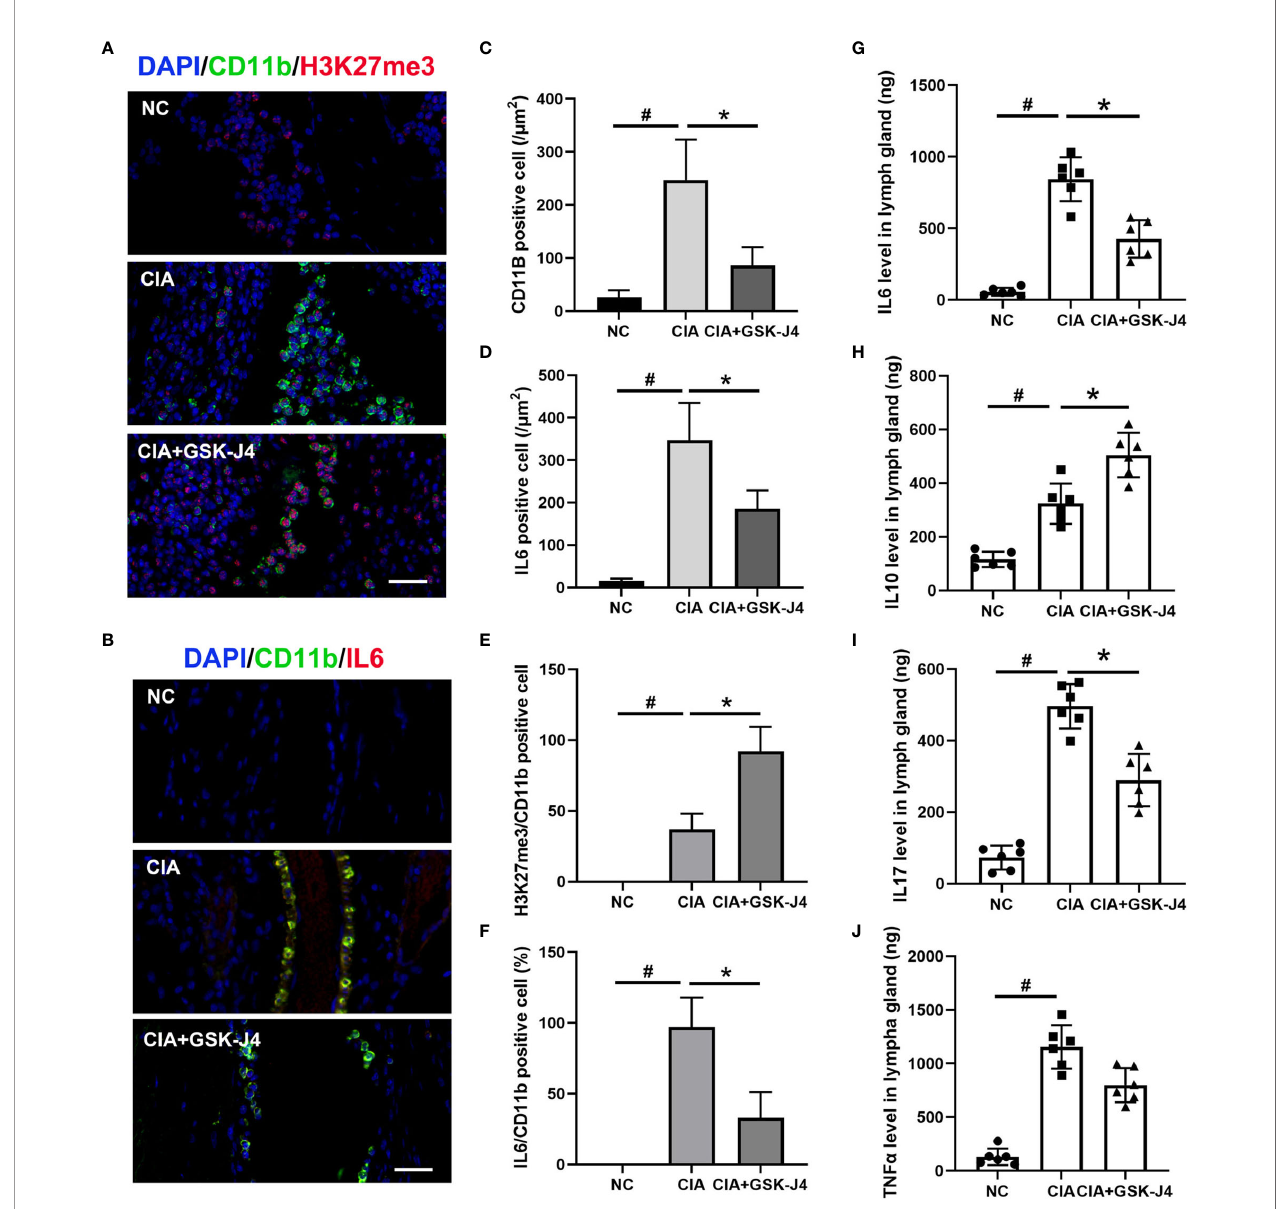
FIGURE 2 | GSK-J4 reduces H3K27me3 level and cytokine expression in macrophages in CIA mice. (A) Immuno fl uorescence staining of H3K27me3 (red) and CD11b (green) positive cells on CIA mice joints, the scale bars represent 100 m m. (B) Immuno fl uorescence staining of IL6 (red) and CD11b (green) positive cells, the scale bars represent 100 m m. (C, D) Average fl uorescence intensity of IL6 and CD11b positive cells. (E, F) The proportion of H3K27me3 and IL6 in CD11b positive cells. (G – J) The concentration of IL6, IL10, IL17 and TNF a in mice lymph gland were detected by ELISA. p < 0.05 (two-tailed Student ’ s T-test) is indicated by * for comparison with CIA vs. CIA+GSK-J4, # for comparison with NC vs. CIA, error bars indicate